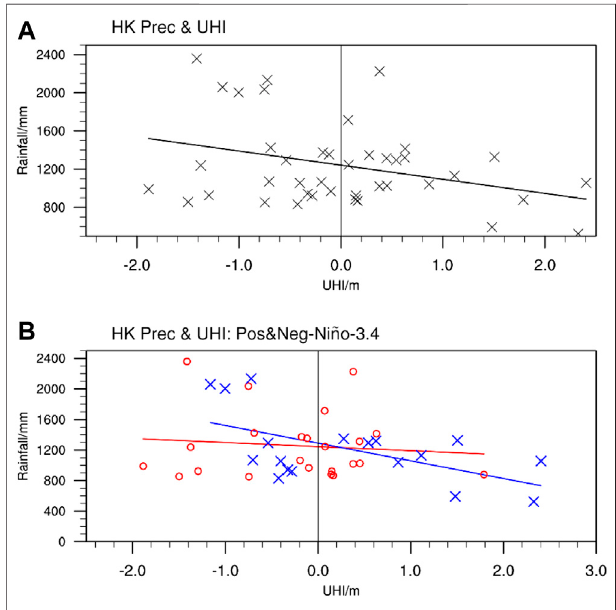
FIGURE 2 | (A) Scatterplot of HK Prec (mm) against the standardized Ural Height Index (UHI, m) in summer, where the straight line represents the least square fi t. (B) Same as (A) , but for positive Niño-3.4 summers (red) and negative Niño-3.4 summers (blue)